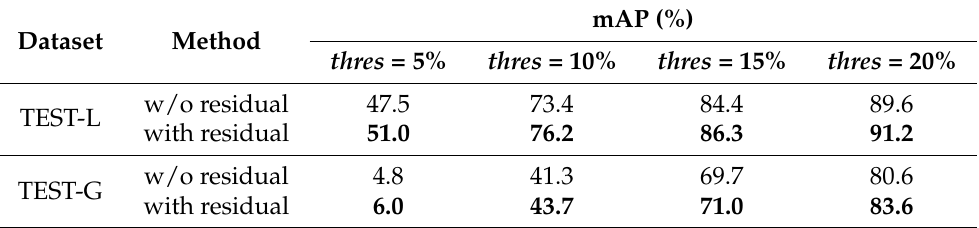
Table 6. Ablation study on parameter values prediction (w/o residual: regress the prediction without residual